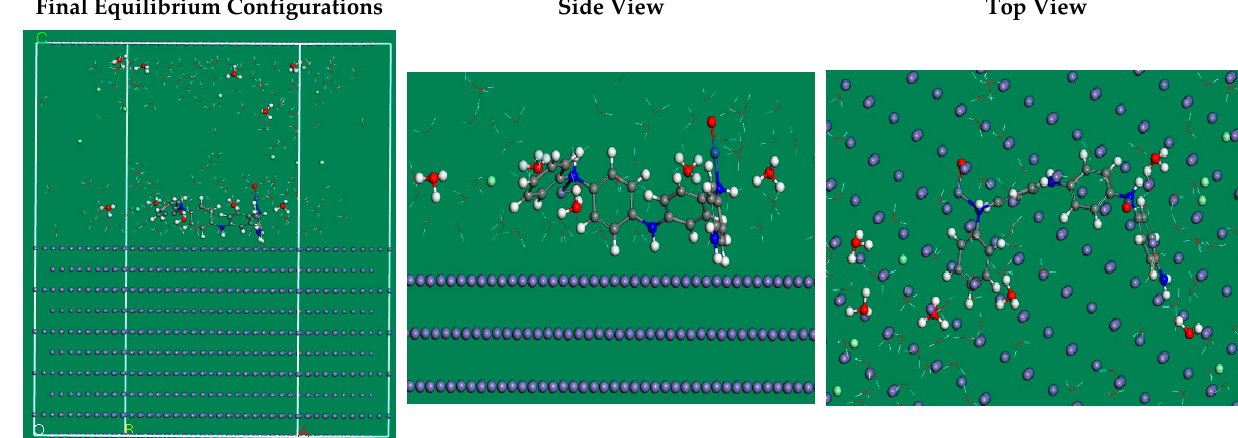
Figure 12. The highest suitable adsorption configuration based on the adsorption Locator module for the ZnNiO@PANE molecule on iron (110) Substrate. Table 4. Information and parameters derived from MC simulations of the PANE, ZnO@PANE, and